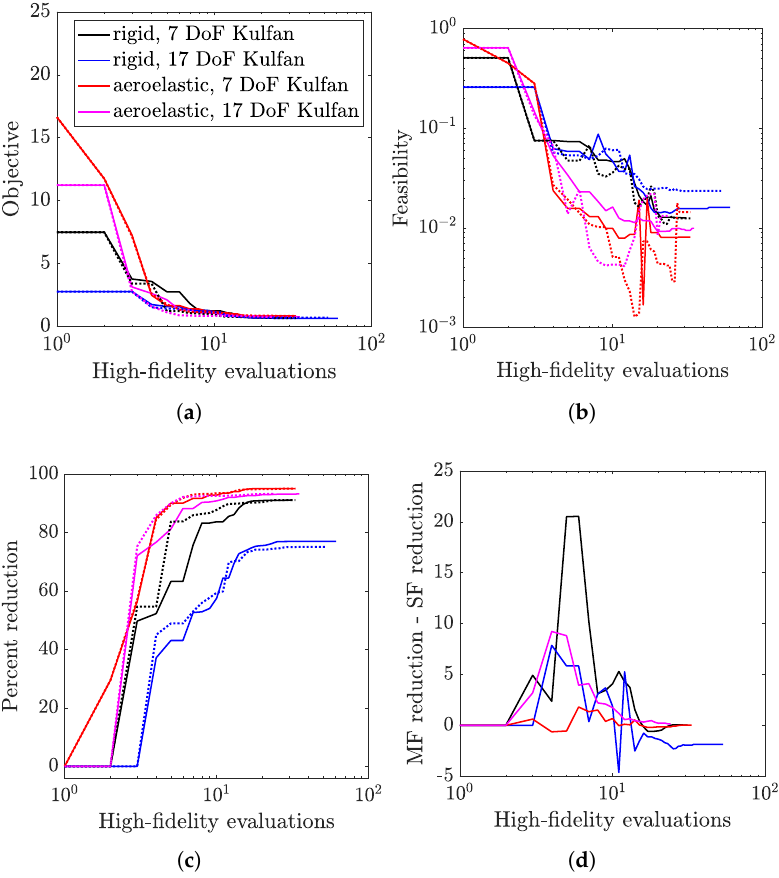
Figure 11. Optimization results for airfoil design cases. In ( a – c ), solid and dotted lines represent single- and multi-fidelity results, respectively. ( a ) Penalty-constrained objective; ( b ) Feasibility; ( c ) Percent reduction, all; ( d ) Percent reduction,